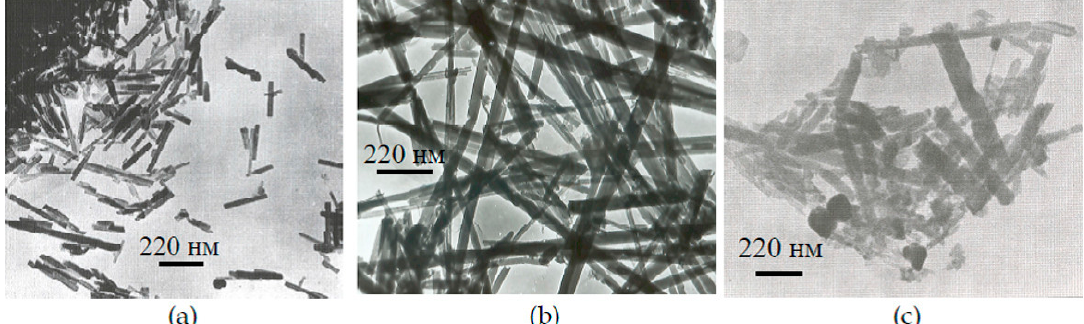
Figure 22. Micrographs of Mg 3 Si 2 O 5 (OH) 4 SNTs with a cylindrical morphology and various dimensions: ( a ) SNT-I; ( b ) SNT-II; and ( c ) SNT-III [112].